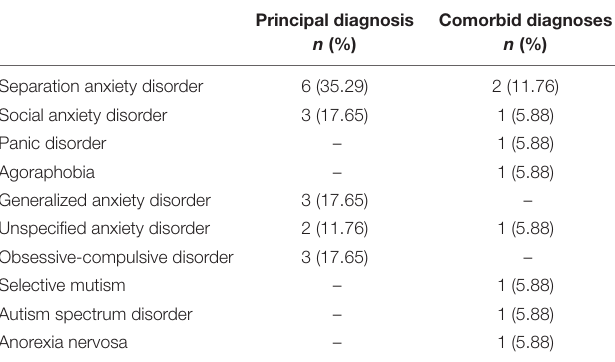
TABLE 1 | Principal and comorbid diagnoses at pre-treatment. TABLE 2 | Five Skills of the UP-C: Contents and names in the original and Japanese versions.